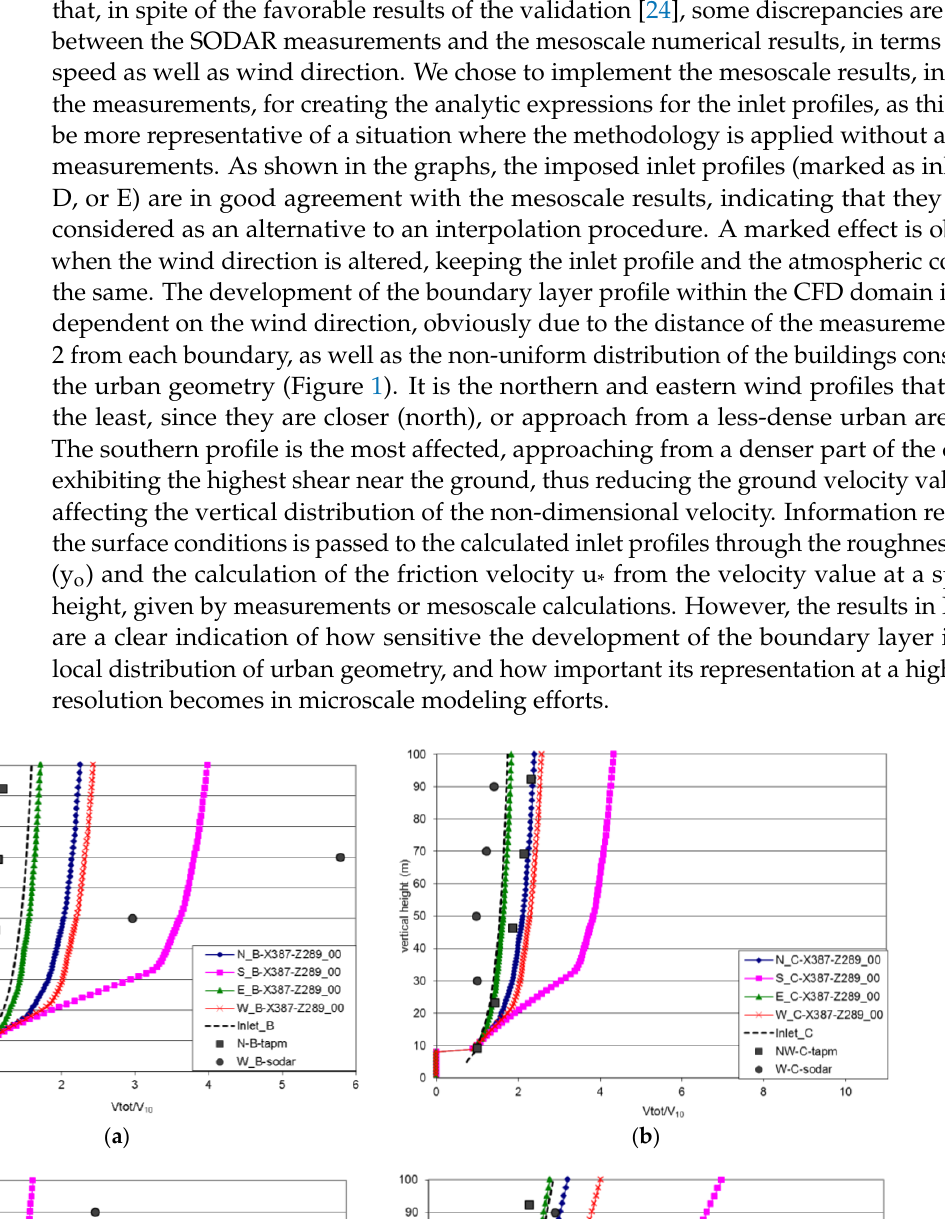
( d ) Figure 5. Vertical profiles of wind speed over position 2 (Figure 1) at four stability conditions ( a ) D, ( b ) C, ( c ) B, ( d ) E (Table 1). Comparison of CFD results using two different turbulence models (k- ε and SST) and SODAR measurements. Mesoscale results (“TAPM - inlet”) are also shown.